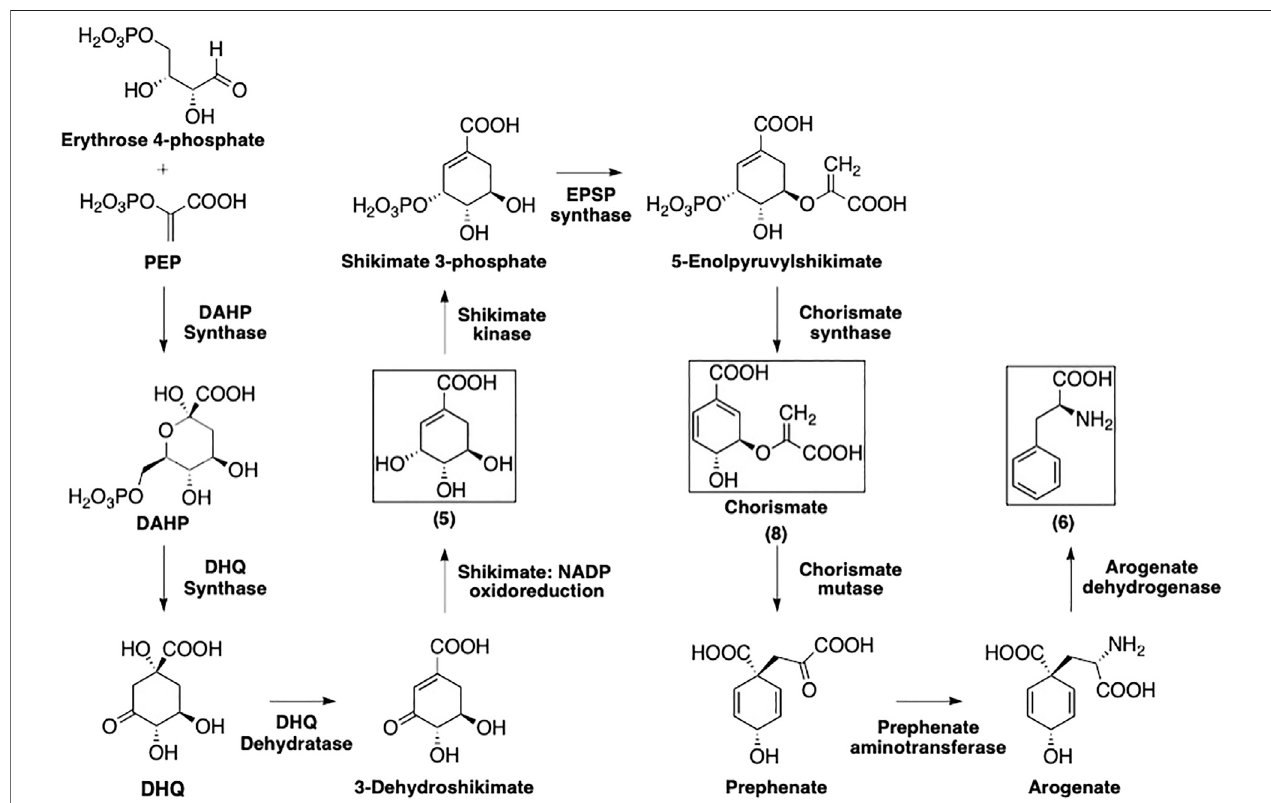
FIGURE 3 | Formation of phenylalanine following the shikimate pathway. Squared boxes indicate relevant intermediates.